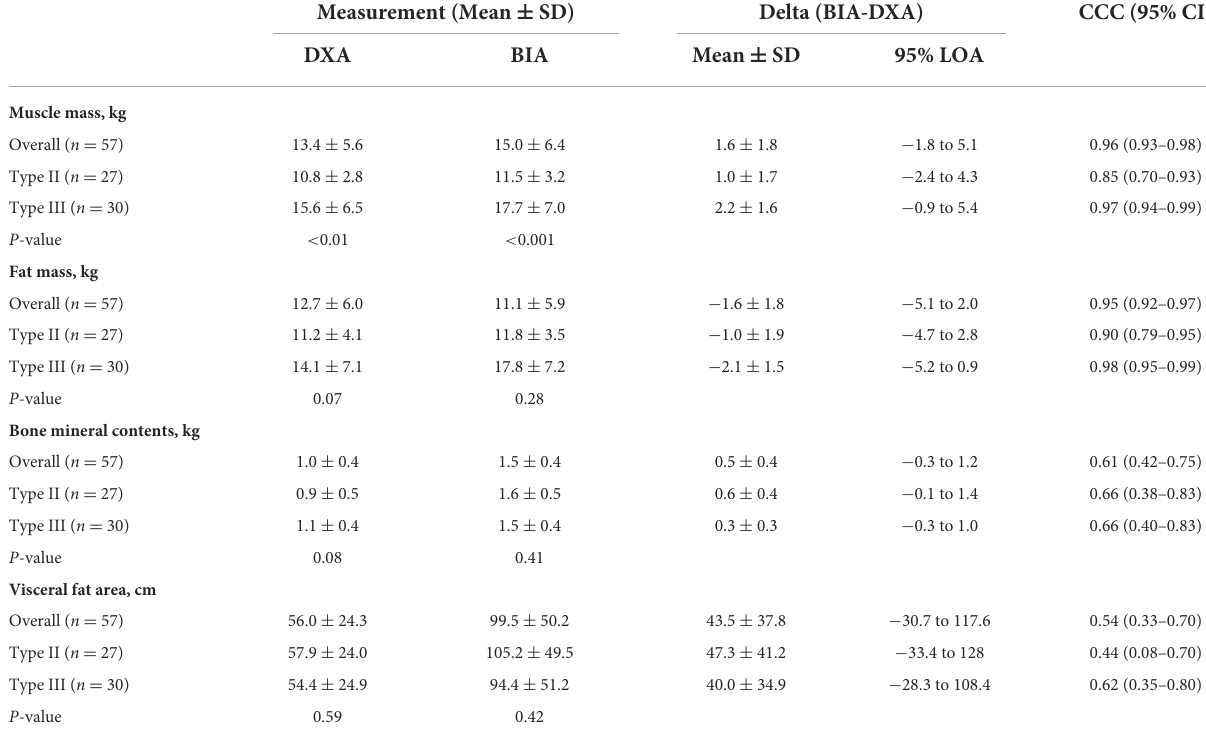
TABLE 2 Agreement between the measurement results of DXA and